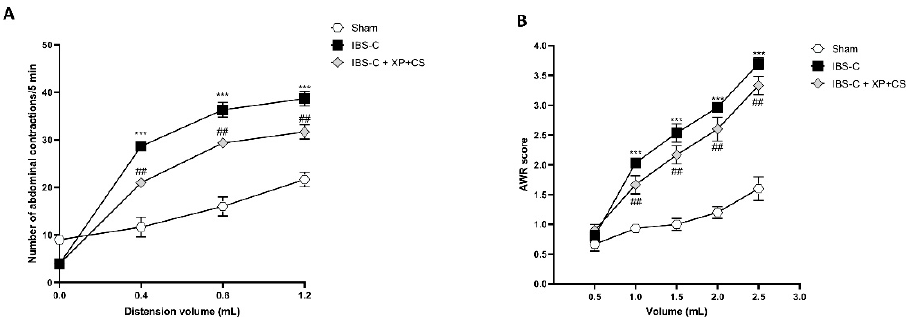
Figure 4. XP and CS considerably decreases abdominal pain following IBS-C. ( A ) Number of abdominal contractions measured in 5 min in Sham, IBS-C and IBS-C + XP + CS groups; ( B ) AWR to colon rectal distension (0.5, 1, 2, 3 mL balloon inflation) in Sham, IBS-C and IBS-C + XP + CS groups. *** p < 0.001 vs. Sham; ## p < 0.01 vs. IBS-C.